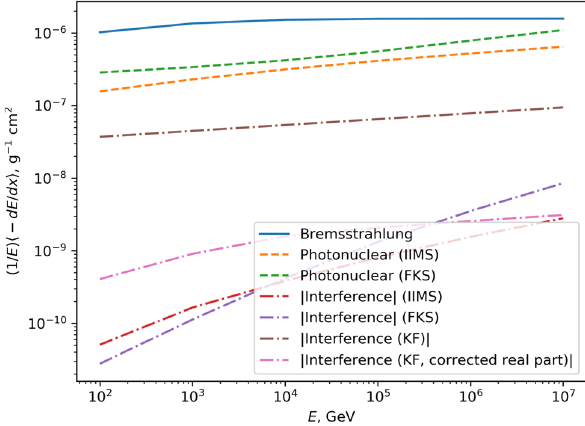
Fig. 4 Bremsstrahlung, photonuclear, and interference energy loss of muons on standard rock